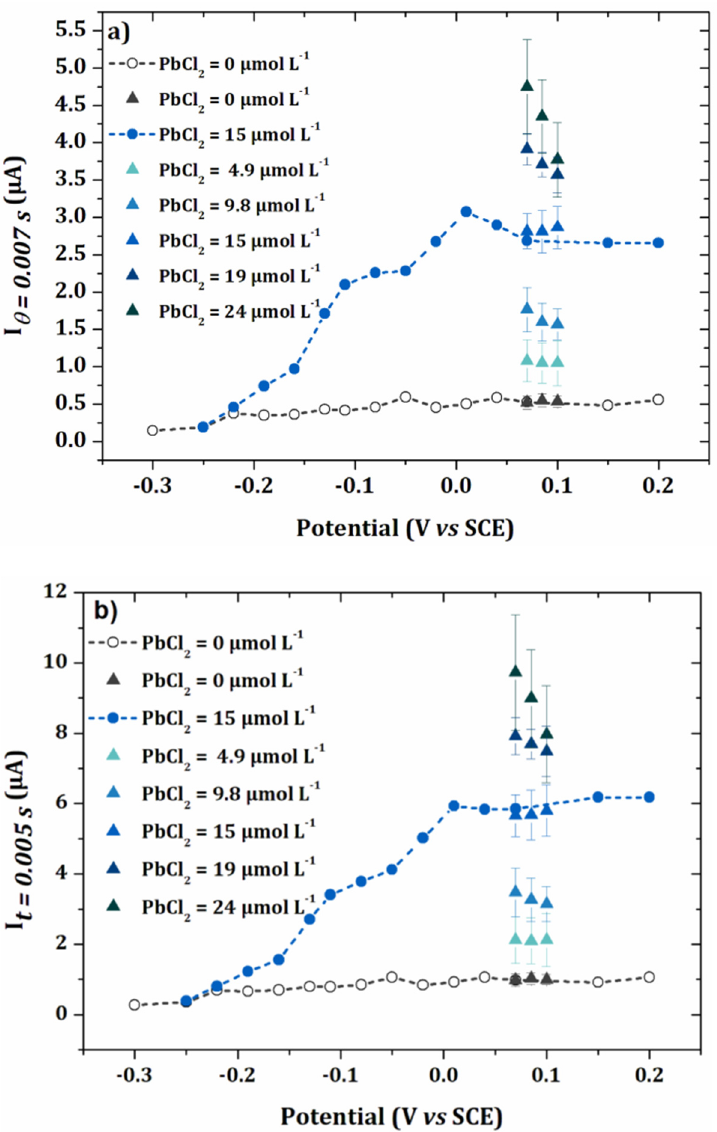
Figure 9. I-E curves obtained for the blank and 15 μ mol L − 1 PbCl 2 in 0.1 mol L − 1 NaCl. Values of current for applied potentials of 0.07 V/SCE, 0.085 V/SCE and 0.1 V/SCE for PbCl 2 concentrations ranging from 15 μ mol L − 1 to 24 μ mol L − 1 (error bars are based on 3 repetitions) and for the blank (error bars are based on 5 repetitions). (a) 𝜃 = 0.005 s and (b) 𝜃 = 0.007 s.